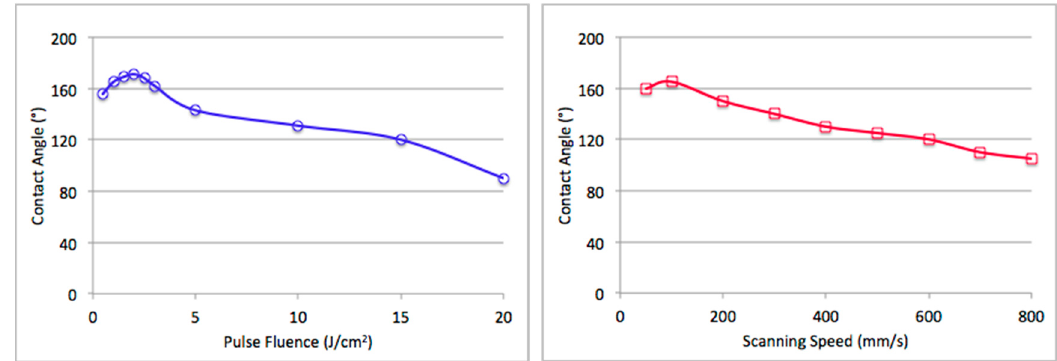
Figure 5. The contact angle versus pulse fluence at a scanning speed of 100 mm/s and pitch of 5 µm (left). The contact angle versus scanning speed at a pulse fluence of 2 J/cm 2 and pitch of 5 µm (right).